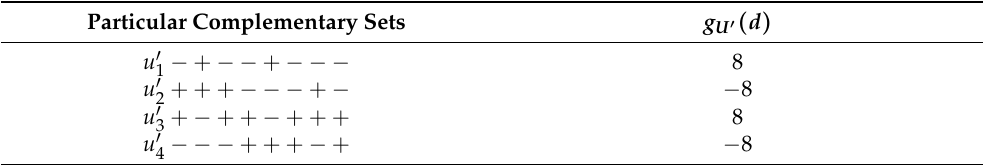
Table A2. Example for the illustration of Property 1 ( L = 8).